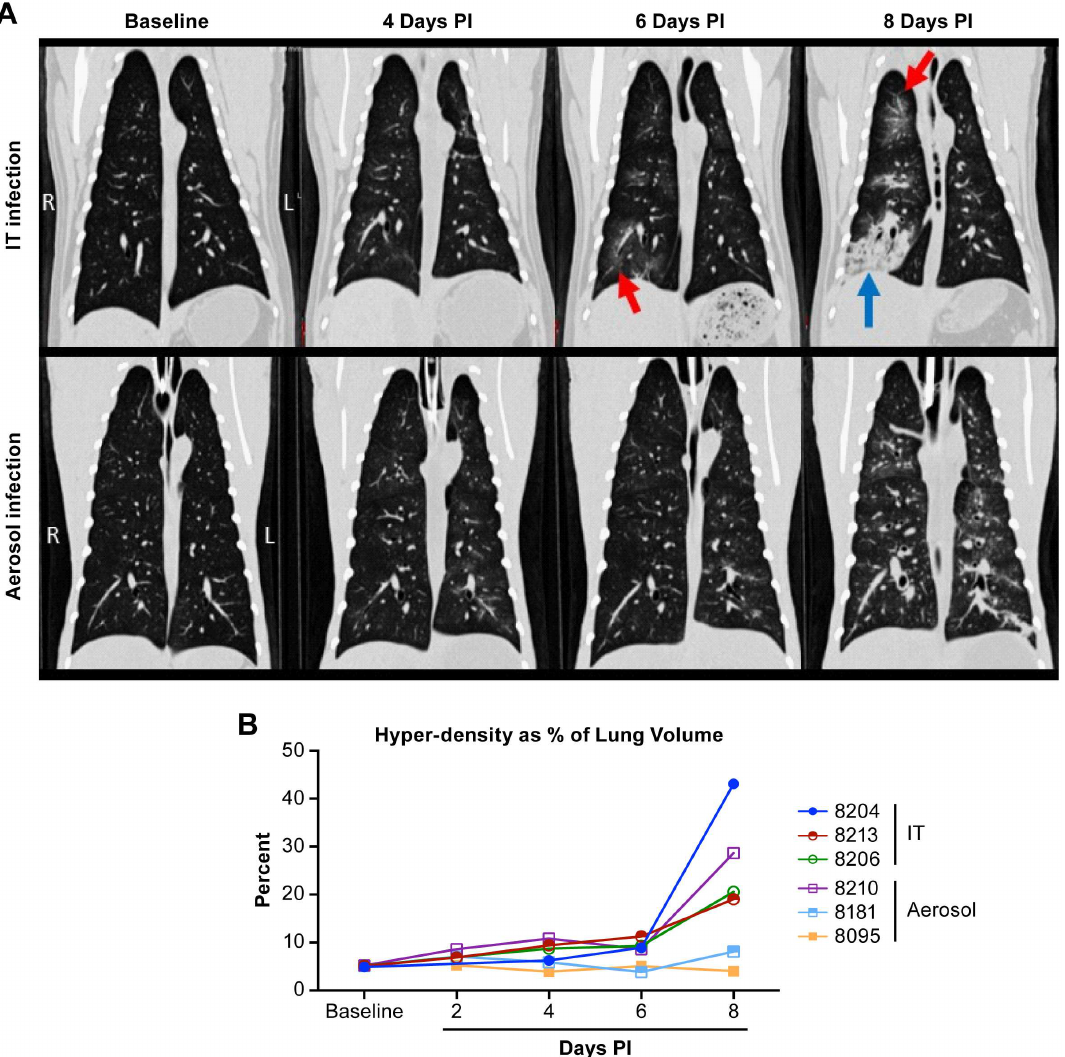
Fig 4. CT analysis of the lungs of NiV infected AGMs. Examplesof temporalanalysisof changeswithin the lungs of AGMs infected by intratracheal or aerosolinoculation(A). In animalsinfected by the IT route, images shows a vascular pattern of infiltrationextendingto adjacent alveoli,manifestedas radiating groundglass opacities(indicated by red arrows), progressing by day 8 to diffuse lobar consolidation (blue arrows) that tends to extend from cranial to caudalin severity. In animalsinfected by aerosolization of small particles, diffuse progressivethickeningof airway walls and adjacent interstitium are typically observable within 6 days of infection, which ultimatelyextends into the alveoli, uniformly throughoutthe lungs. Where IT inoculation tends to inducesome amount of consolidation, typically in caudal lobes, infection by small particle aerosolappearsto cause disseminated pulmonarychangesthroughout all lobes. Quantification (B) of lung volume demonstrates that animalslost up to 45% of their total lung volume with all three of the animalsinfected by IT inoculation losing18% or greater of their lung volume.